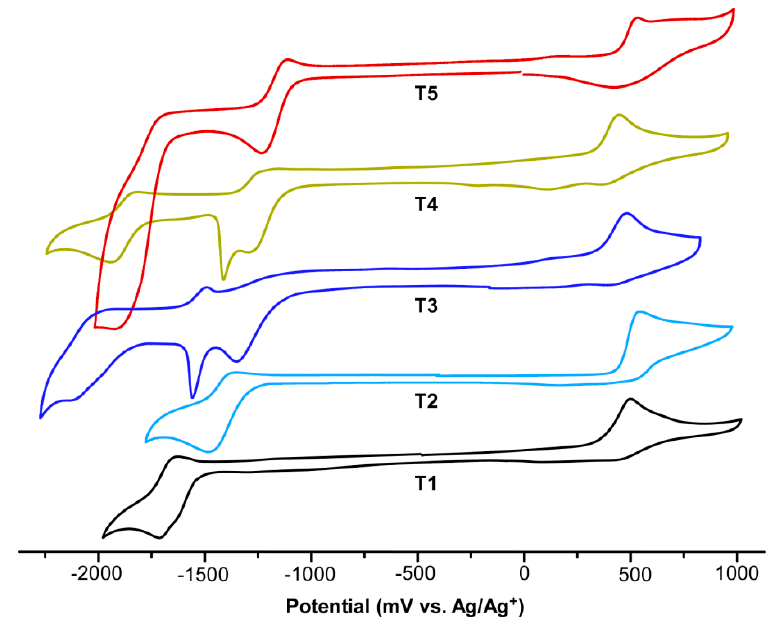
Figure 6. Cyclic voltammograms of thieno[3,4- b ]pyrazine-based terthienyls T1 – T5 .